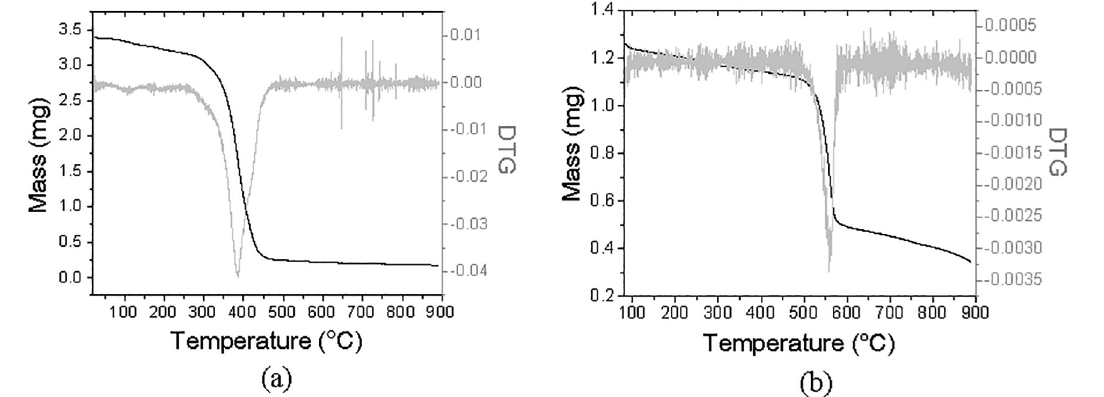
Figure 2. Thermogravimetry test: (a) Polyester Ortho-terephthalic resin; (b) Kevlar